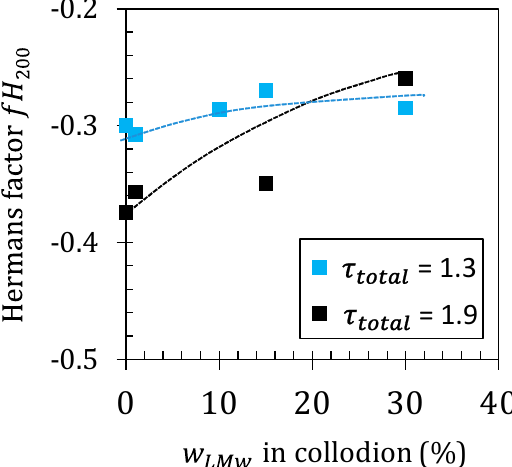
Figure 6. Evolution of the apparent Herman’s orientation factor ( f H 200 ) with the LMW fraction w LMw in the spun fibers, estimated for processing performed at low and high total stretching ratio ( τ total ).